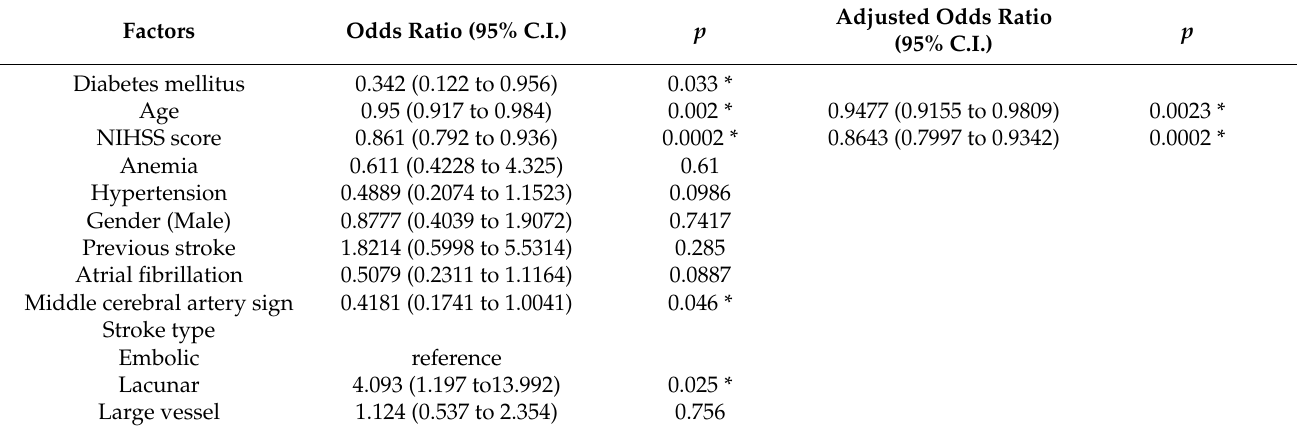
Table 3. Logistic regression in the training